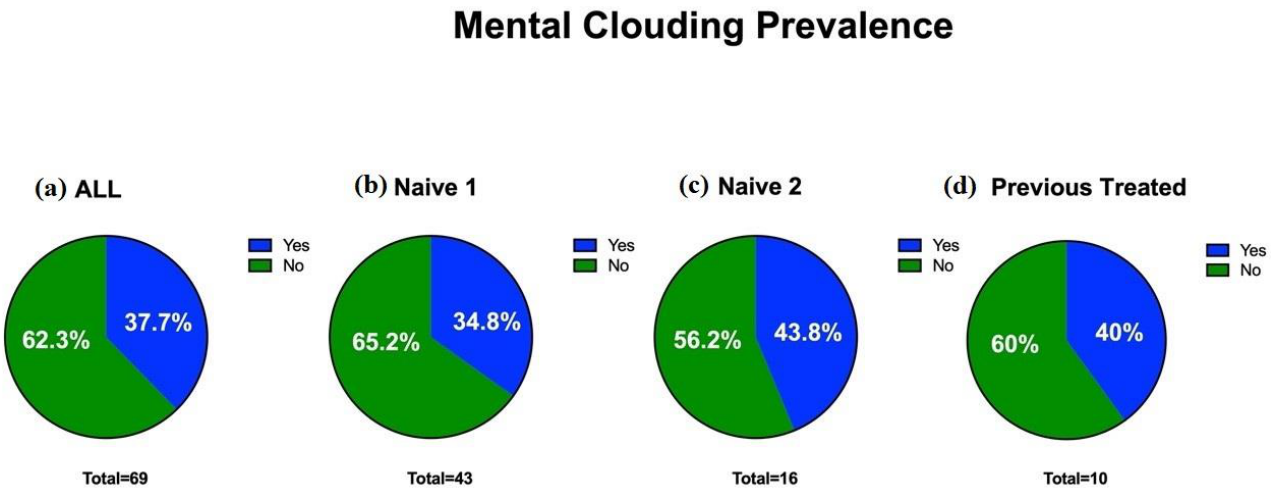
Figure 3. Prevalence of mental clouding in the cohort at baseline: ( a ) overall prevalence of parosmia in the sample; ( b ) prevalence in individuals naïve to therapy 1; ( c ) prevalence in individuals naïve to therapy 2; ( d ) prevalence in previously treated individuals.